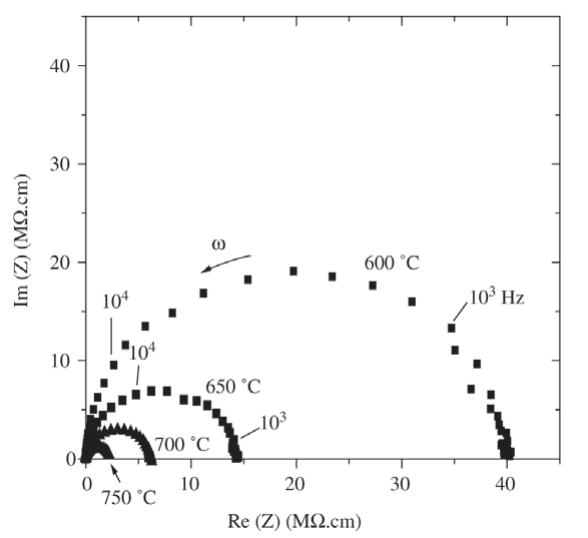
Figure 2. Complex impedance diagrams of Bi Ge O single crys- 4 3 12 750 °C, fitted to an equivalent RC parallel circuit. The numbers indicate the signal